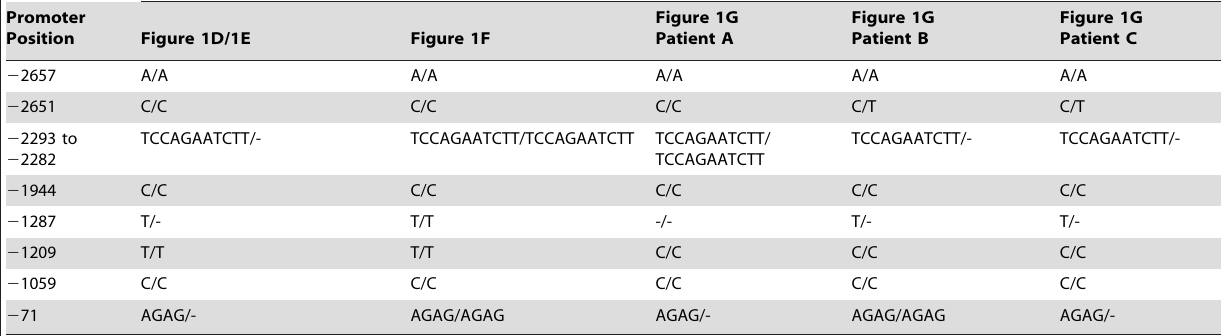
Genotype of patient samples used in real-time expression Promoter Position Figure 1D/1E Figure 1F